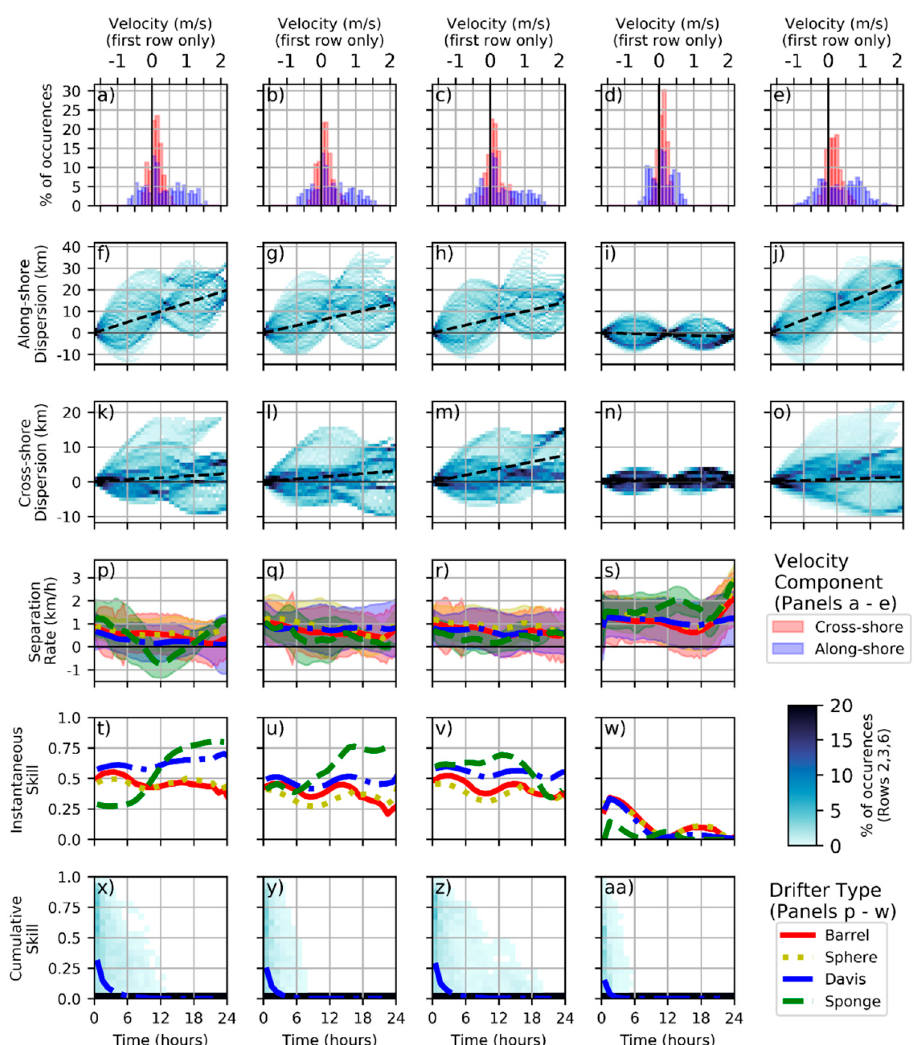
Figure 9. Results of the drifter analysis for the simulated drifters using the FVCOM (left column), SJAP100 (second from left), BoF500 (middle), WebTide (second from right), and observations where applicable (right column). Distributions of along-shore (blue) and cross-shore (red) drifter velocity (for the Davis drifters) are shown in the first row ( a – e ). Absolute dispersion in the along-/cross-shore directions (for the Davis drifters) is shown in the second and third row ( f – o ) with the mean drift superimposed on the density of the simulated/observed positions in each direction. Separation rate between the simulated drifters and the corresponding observations is shown in the fourth row ( p – s ) for all four drifter types. Instantaneous skill corresponding to the various model predictions is shown in the fifth row ( t – w ) for all drifter types, and the cumulative skill for the prediction of the Davis drifter trajectories is shown in the sixth row ( x – aa ), with the mean cumulative skill as a function of time is shown as a solid blue line.